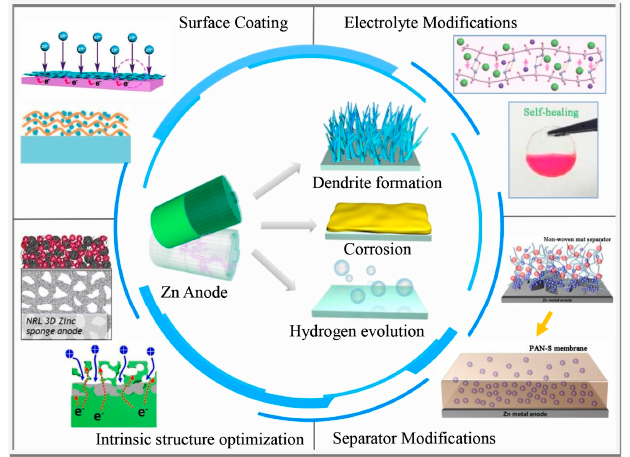
Figure 1. Schematic of unfavorable effects and stabilization strategies for Zn anode. Reproduced with permissions from Ref. [15]. Copyright © 2022 WILEY-VCH.